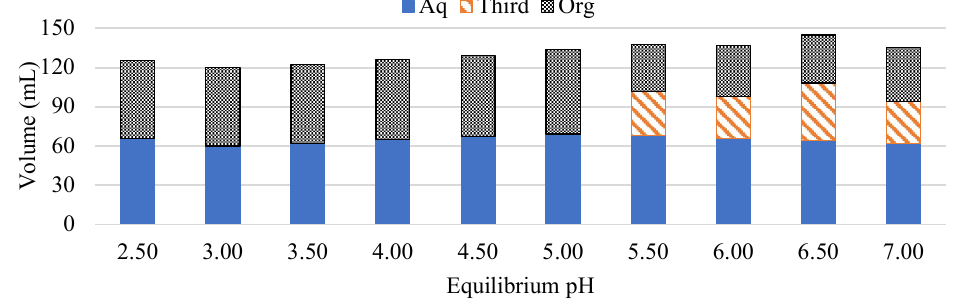
Figure 6. Phase volume distribution as a function of pH.